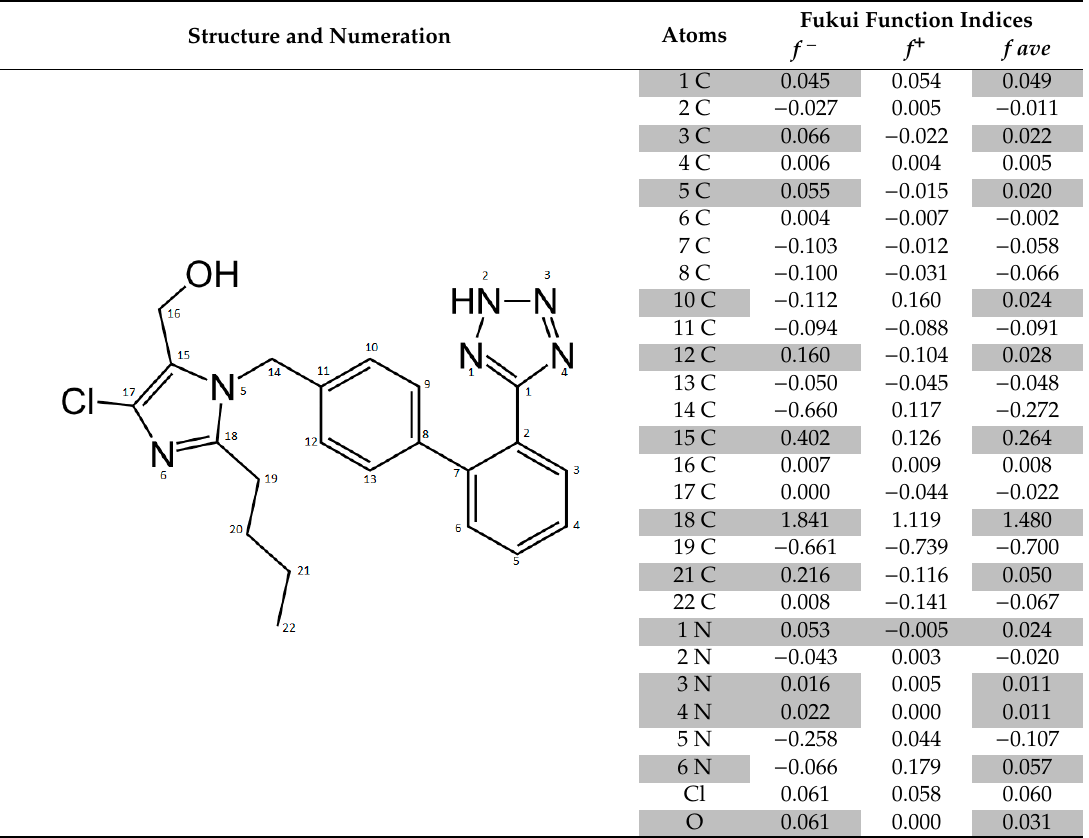
Table 3. Results of computational analysis for losartan 1